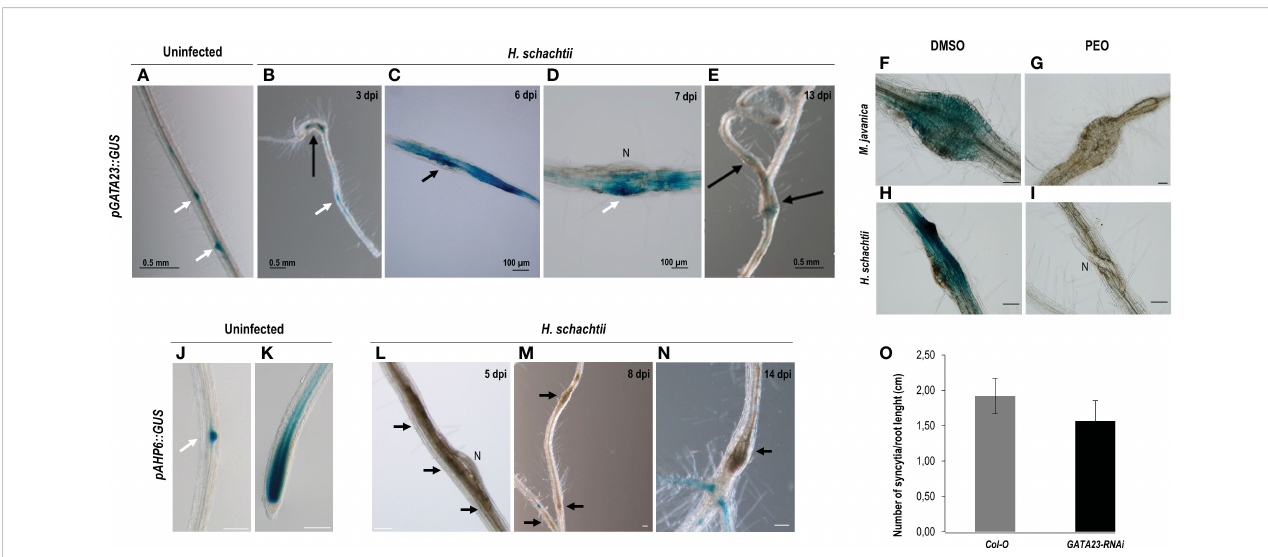
FIGURE 1 Activation patterns of pGATA23::GUS and pAHP6::GUS in the infection sites induced by Heterodera schachtii in Arabidopsis. The expression in uninfected tissues, used as positive control was centred in the lateral root primordia (A) . GUS staining of pGATA23::GUS Arabidopsis roots infected by H . schachtii within the infection sites at early infection stages ( B – D ; 3 – 7 days post inoculation; dpi), that decreased at 13 dpi (E) . GUS staining of RKN and CN infection sites at 7 dpi of the pGATA23::GUS line untreated and treated with PEO-IAA (IAA transduction inhibitor; F – H , and G – I ; respectively). An RNA interference line of GATA23, GATA23-RNAi , showed no differences in the establishment of (H) schachtii compared to the control (Student ’ s t-test, p <0.05) (O) . No GUS staining was detected in the pAHP6::GUS line at early (5 – 8 dpi; L, M ), or medium-late stages of syncytia development (14 dpi; N ). GUS signal was detected in the positive control, uninfected tissue at lateral root primordia and root tip ( J, K , respectively) as previously described (Moreira et al., 2010). Black arrows indicate the presence of the syncytia. Scale bars: 100 μm (F – N) , white arrows, lateral root primordia, N, nematode. At least 50 independent plants per line and infection time were assayed for GUS analysis, as well as for the evaluation of the infection parameters of GATA23-RNAi and its corresponding Col-O control line. At least three independent experiments per independent plant line were